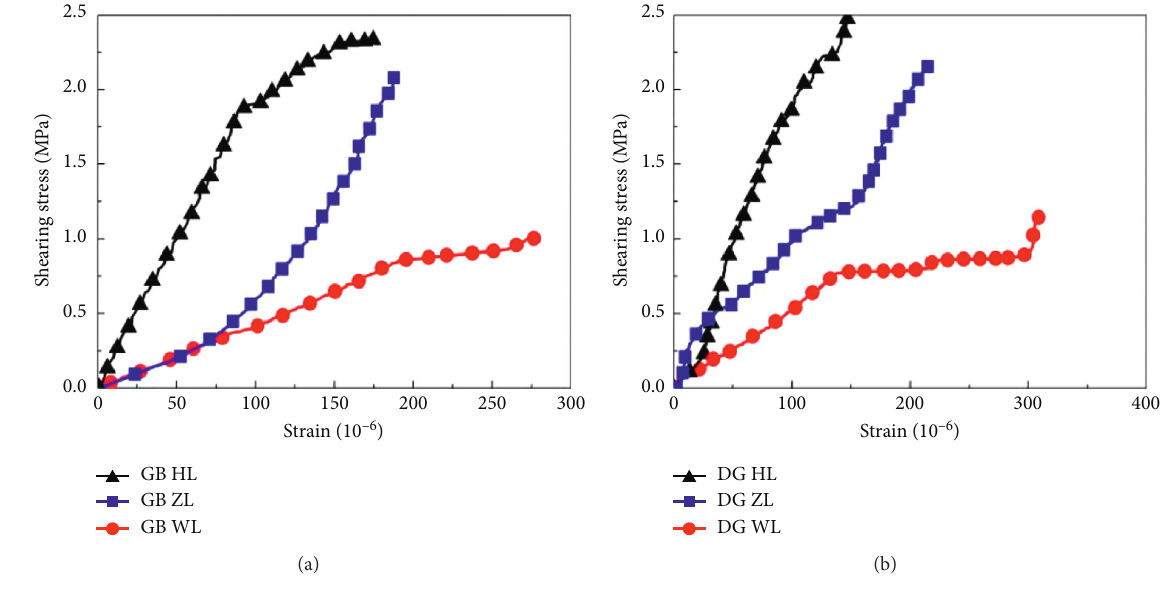
Figure 11: Stress-strain curves of the interface: (a) GB and (b) DG.